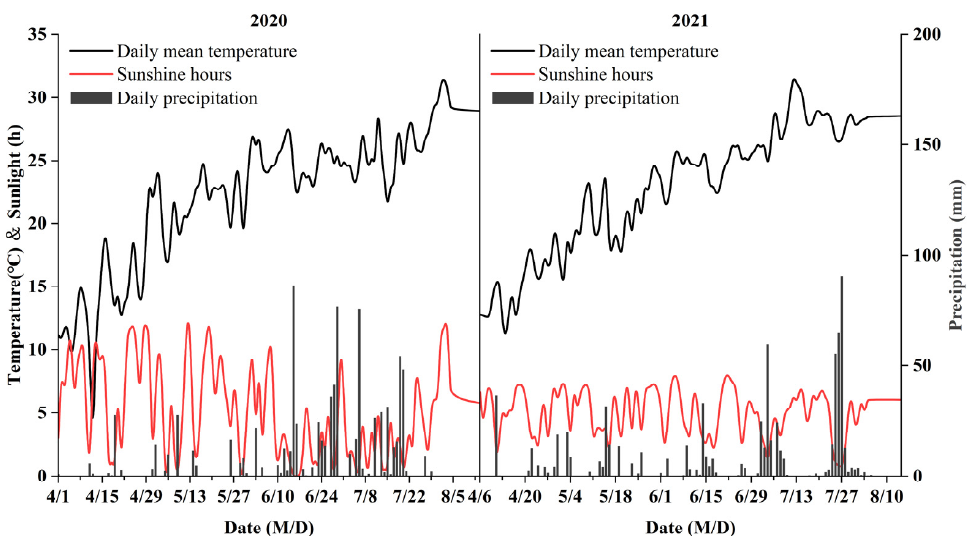
Figure 4. Daily precipitation, mean temperature and sunshine hours during maize growth seasons in 2020 and 2021.